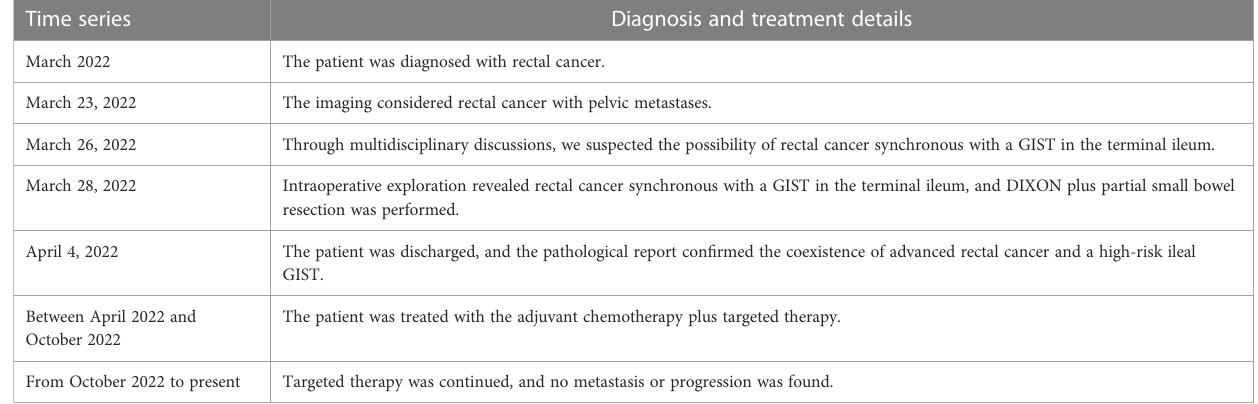
TABLE 1 The medical history of the